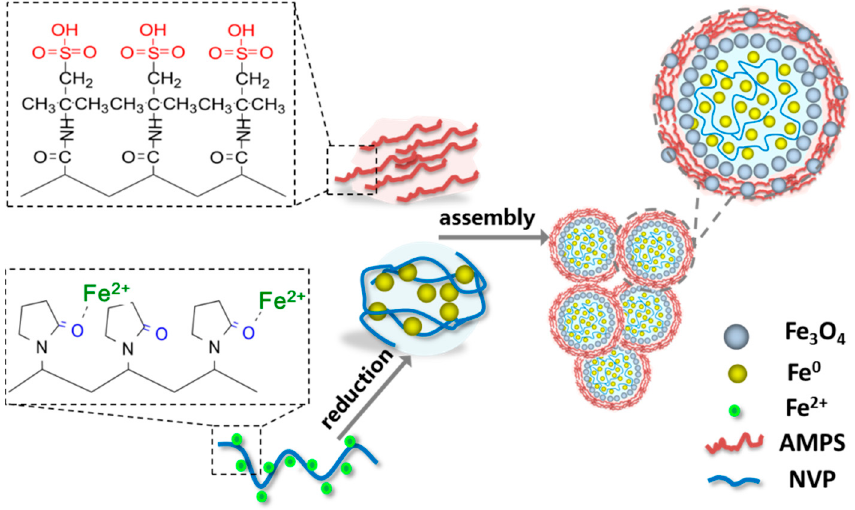
Figure 5. Diagrammatic sketch for speculative regulatory mechanism of NVP and AMPS on the formation of Fe 0 /Fe 3 O 4 microparticles.